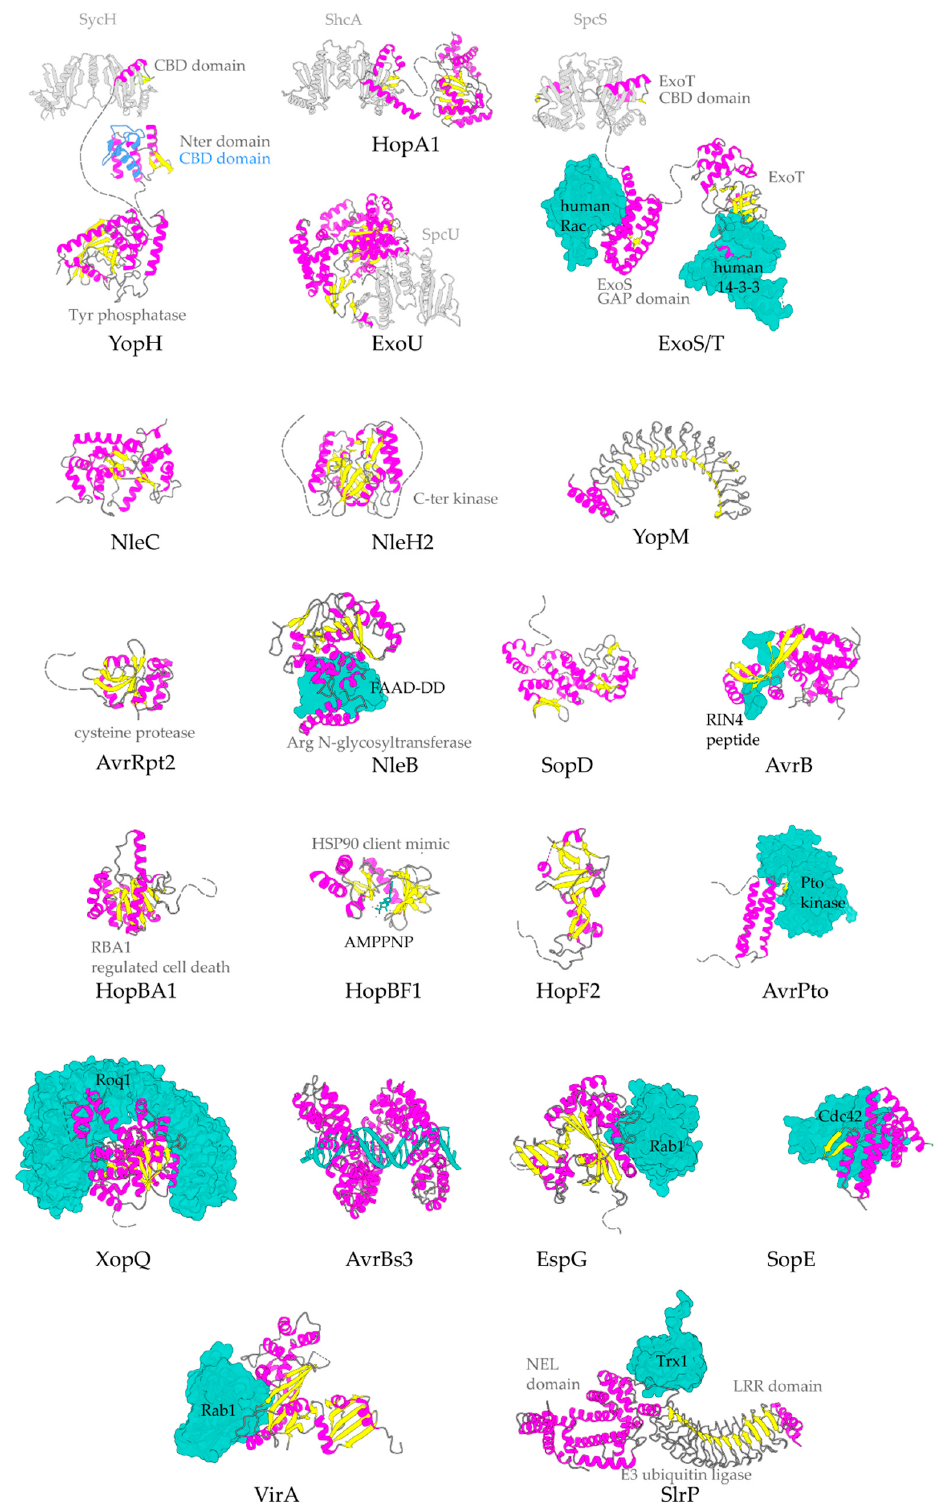
Figure 3. Representative structures for T3SEs. T3SEs are shown in cartoon representation with α -helices in magenta, β -strands in yellow, rest of secondary structure in grey. N-terminal and C-terminal unstructured parts are depicted here in grey broken lines. Dimeric T3SS class I chaperones (or chaperones of effectors) are displayed in grey cartoon representation. Host protein targets that have been co-crystallized with the T3SEs are shown in surface representation in green color. In blue, the alternative conformation of YopH Chaperone Binding Domain (CBD), in the absence of the cognate chaperone. PDB ids used: 1JL5, 4PUF, 4O96, 4O2I, 2QKW, 2NUD, 4FMB, 1GZS, 5CPC, 1S21, 3TU3, 6ACI, 1HE1, 1XXP, 6GNN, 7JLU, 2YPF, 6HQZ, 4RSW, 5T09,